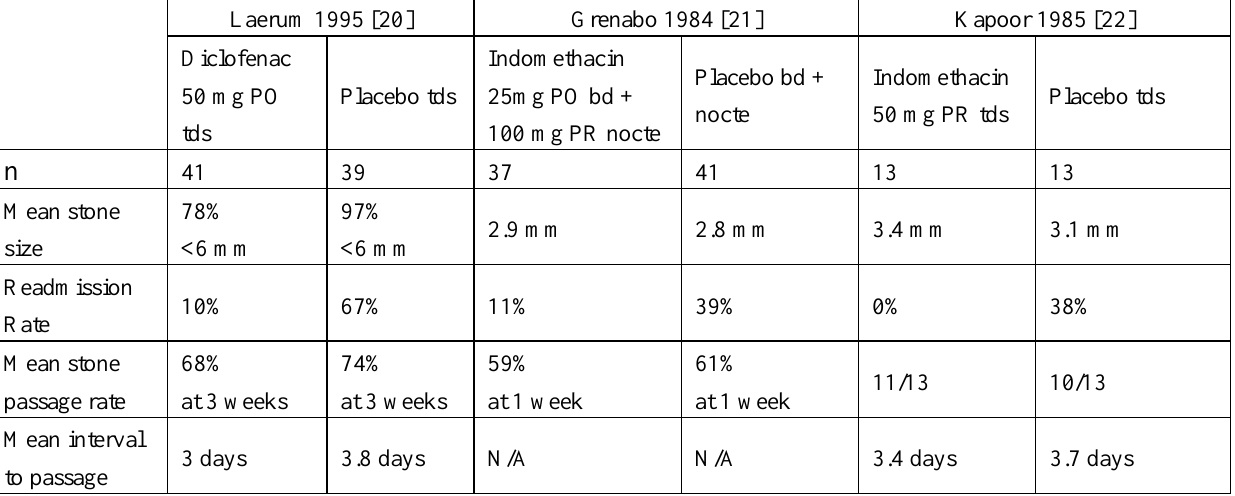
Table 2. The use of NSAIDs for the prophylaxis of pain and promotion of stone passage in acute renal